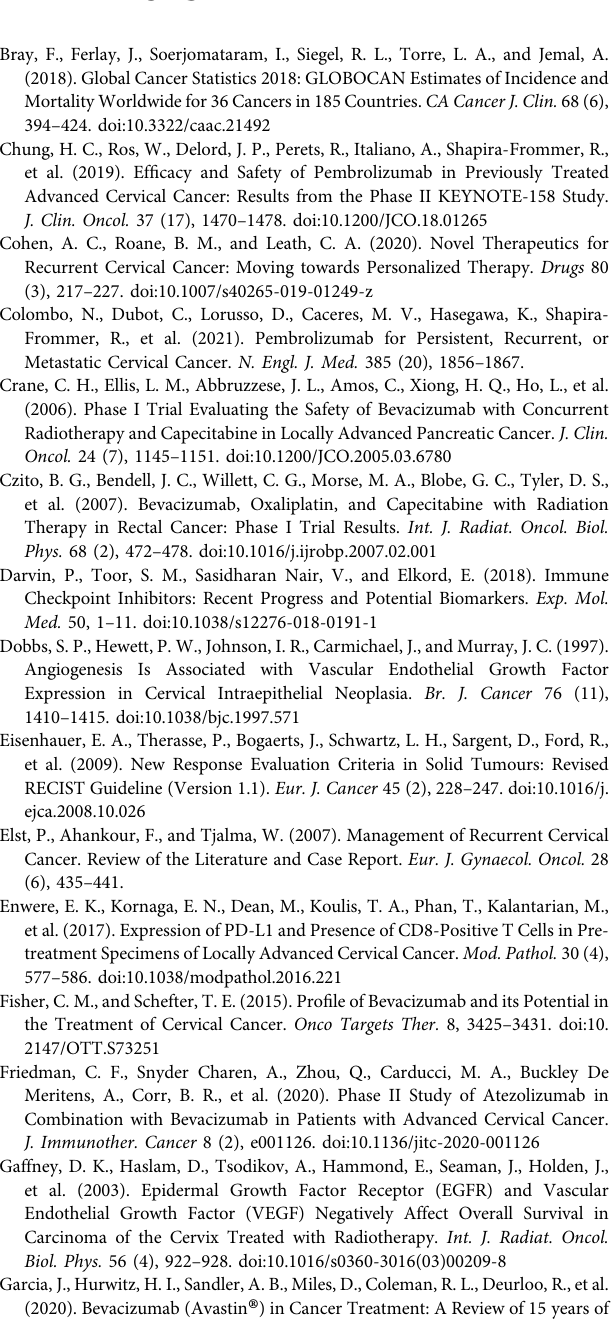
Supplementary Figure S1 | Forest plot about the pooled results of any-grade adverse events. (A) Hand – foot syndrome, (B) hypertension, (C) proteinuria, (D) fatigue, (E) hemorrhage, (F) thrombocytopenia, (G) diarrhea and nausea, and (H) neutropenia. Supplementary Figure S2 | Forest plot about the pooled results of Grade III and higher adverse events. (A) Hand – foot syndrome, (B) hypertension, (C) proteinuria, (D) fatigue, (E) hemorrhage, (F) diarrhea and nausea, (G) neutropenia. Supplementary Figure S3 | Sensitivity analysis. (A) Sensitivity analysis for ORR; (B) sensitivity analysis for DCR; (C) sensitivity analysis for OS; (D)